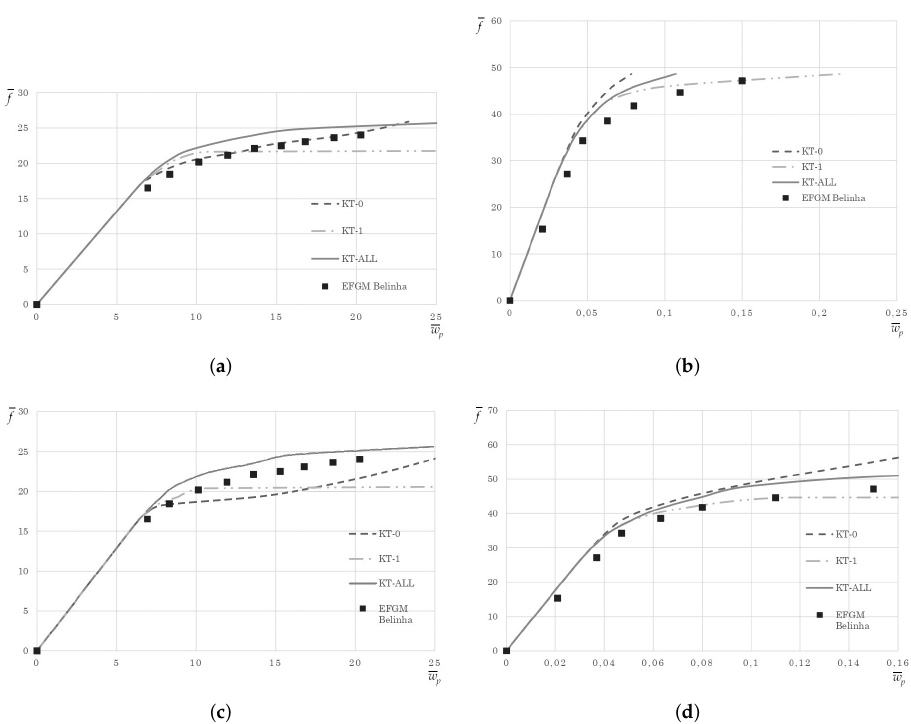
Figure 4. Normalized load-transversal displacement curves obtained with three nonlinear solution algorithms (KT0, KT1, and full Newton–Raphson method—KT-ALL). FEM analysis for the ( a ) simply supported plate and ( b ) the clamped plate. RPIM analysis for the ( c ) simply supported plate and ( d ) the clamped